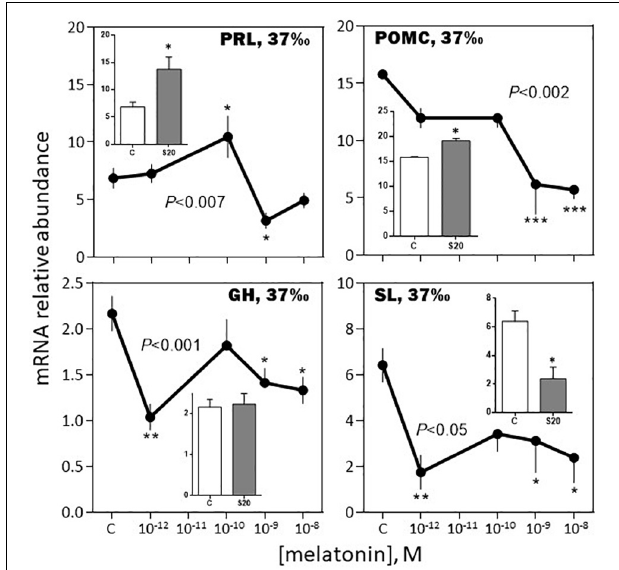
FIGURE 9 | Effects of melatonin and melatonin analogs on PRL, POMC, GH and SL mRNA relative abundance in vitro . The experiment was performed in August using BW fish acclimated to a 37 salinity. Other conditions are as indicated in Figure 6 and in the Materials and Methods section. (cid:104) Mean ± S.E.M. of n = 5 pools (containing 3 glands each). One-Way ANOVA ( P level of significance is indicated within the graph; n.s.: non-significant); values are compared to their respective control (C) using the Holm-Sidak’s pos-hoc test (* P < 0.05, ** P < 0.005, *** P < 0.0005). The insets show the 12 h effects of the melatonin analogs S20304 (S20 at 10 – 8 M). Mean ± S.E.M. of n = 5 pools (containing 3 glands each); values are compared to their respective control (C) using the Student’s t -test at ∗ P < 0.01.